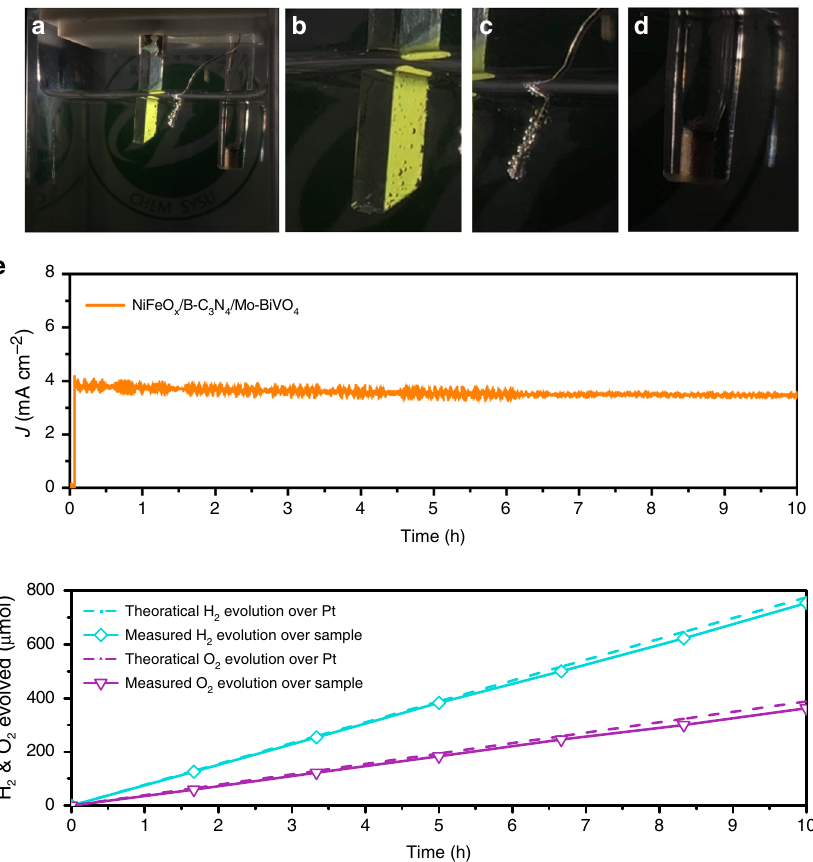
Fig. 5 Photoelectrochemical water splitting performances. Photographs of the NiFeO x /B-C 3 N 4 /Mo-BiVO 4 photoanode in the PEC water splitting system ( a ), the NiFeO x /B-C 3 N 4 /Mo-BiVO 4 photoanode in a blown-up view ( b ), the Pt cathode ( c ), and the Ag/AgCl reference electrode ( d ). e Chronoamperometry (i – t) curve of NiFeO x /B-C 3 N 4 /Mo-BiVO 4 photoanode collected at 0.54V vs. RHE under AM 1.5G illumination in PPB solution (pH 7). f H 2 and O 2 evolution of the NiFeO x /B-C 3 N 4 /Mo-BiVO 4 photoanode at 0.54V vs. RHE; dashed curves indicate the H 2 and O 2 evolution with 98% Faraday ef fi